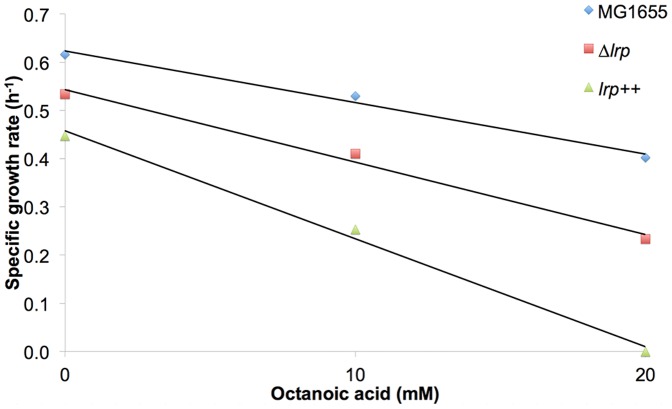
lrp mutations do not improve E.coli growth rate upon addition of octanoic acid. The specific growth rate of strains with altered lrp expression during the log phase in MOPS with 2% dextrose at 37°C, 150 rpm.